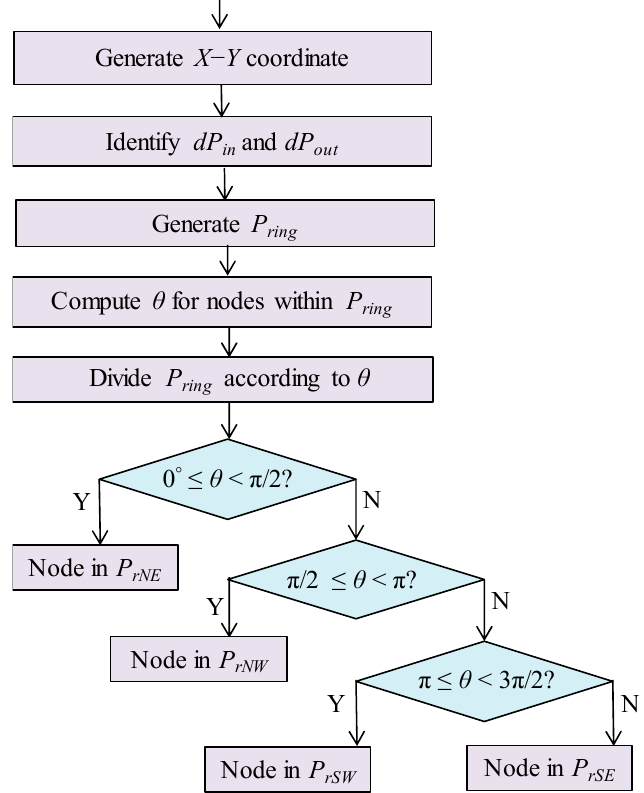
Figure 1. Configuration of the pursue ring ( P ring ) regions in the proposed PhaP protocol.